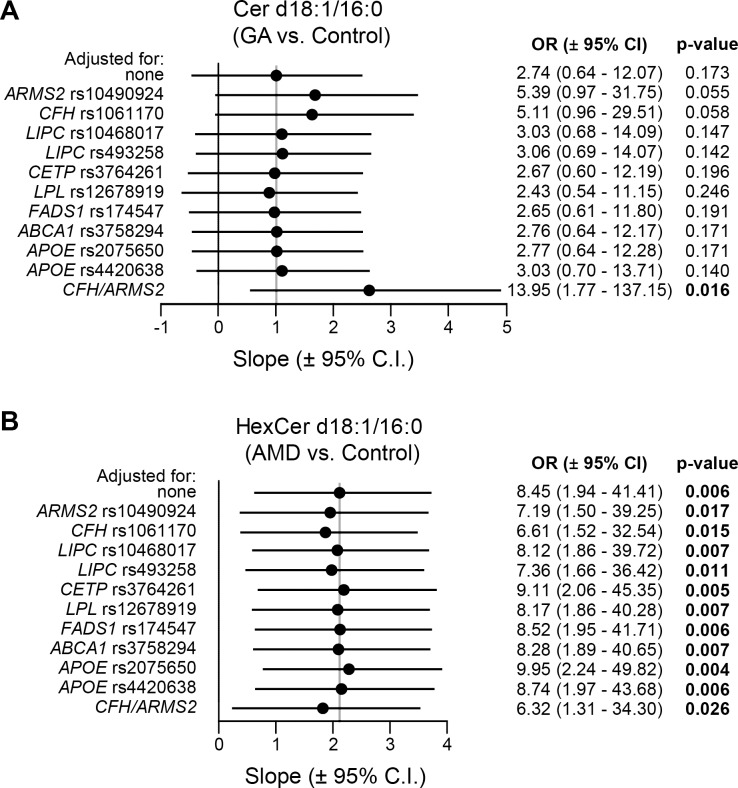
Sensitivity analysis of ceramide species against selected AMD associated genetic variants.A subgroup of genotyped samples including controls (n = 94), geographic atrophy (GA, n = 31) and choroidal neovascularization (CNV, n = 161) was used to determine the influence of genetic variants in the association of lipid species and disease by multiple logistic regression. Regressions were adjusted for age, sex, batch and genetic variants for: (A) Ceramide (Cer) d18:1/16:0 association with GA, (B) Hexosylceramide (HexCer) d18:1/16:0 association with all late AMD (i.e. AMD = GA + CNV). The vertical grey lines indicate the slope of the regression non-adjusted for genetic variants. Odd ratios (OR) ± 95% confidence intervals (CI) are shown together with the p-values of the regressions. CFH/ARMS2: adjusted for both CFH rs1061170 and ARMS2 rs10490924.